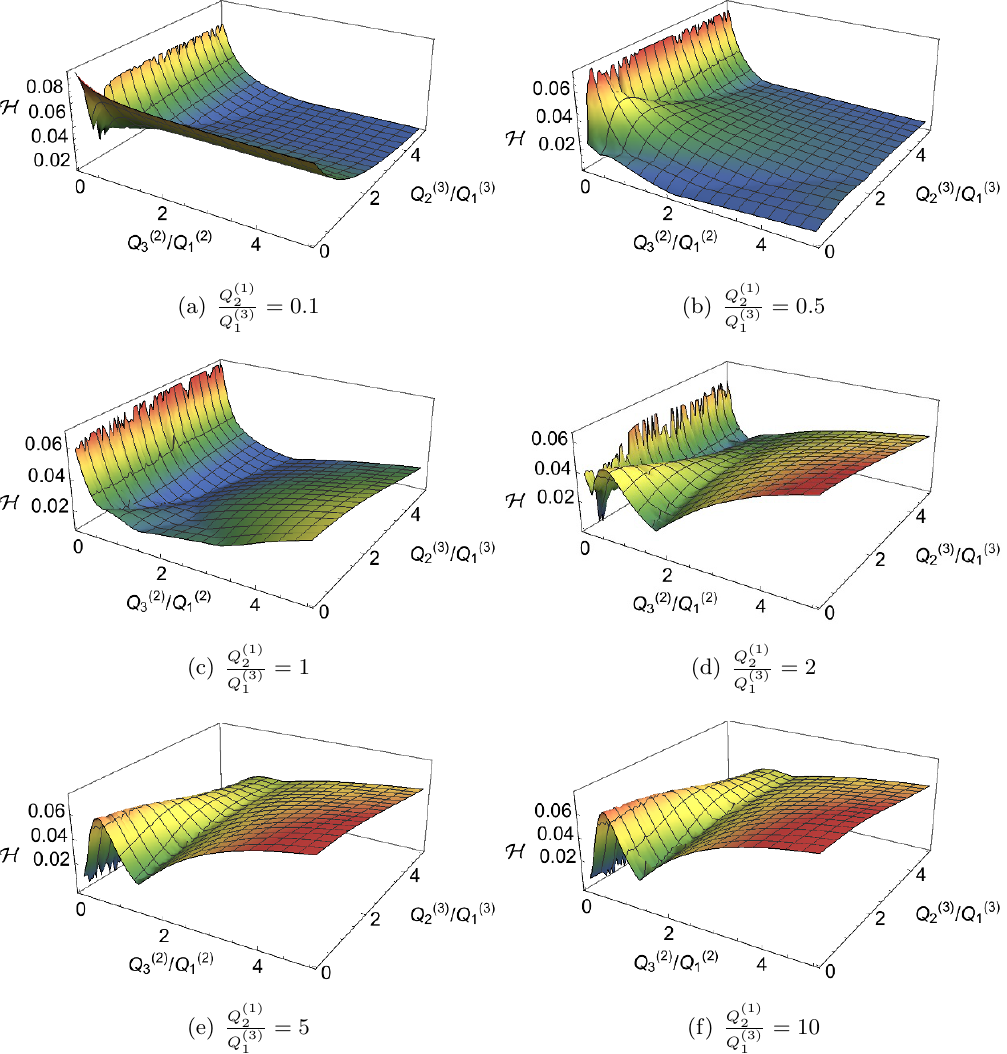
Figure 2 . The entropy parameter H as a function of the charge ratios with q , k 1 , (cid:0) k 2 and k 3 equal to